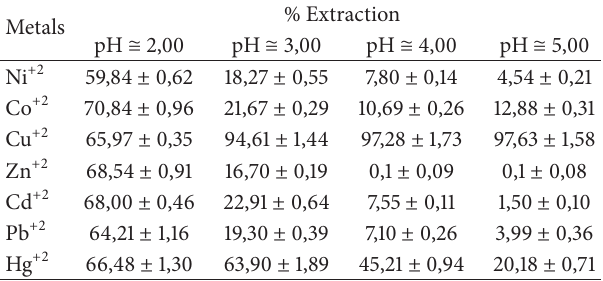
Table 3: Extraction of metal cations with L2 (%).